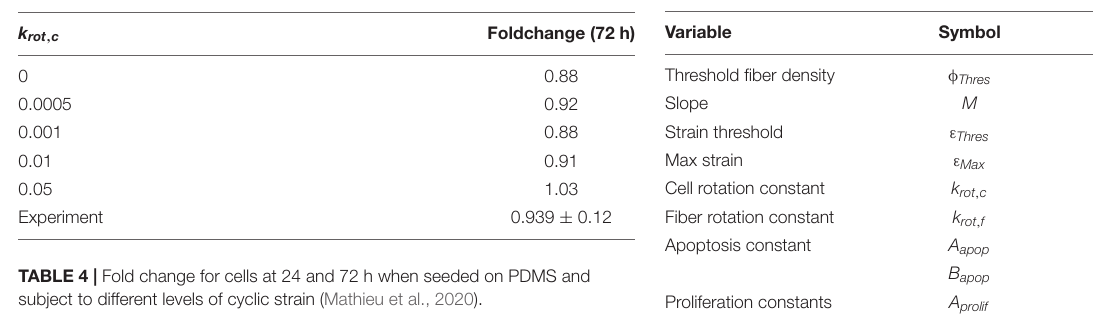
TABLE 5 | Parameters calibrated against experimental data.